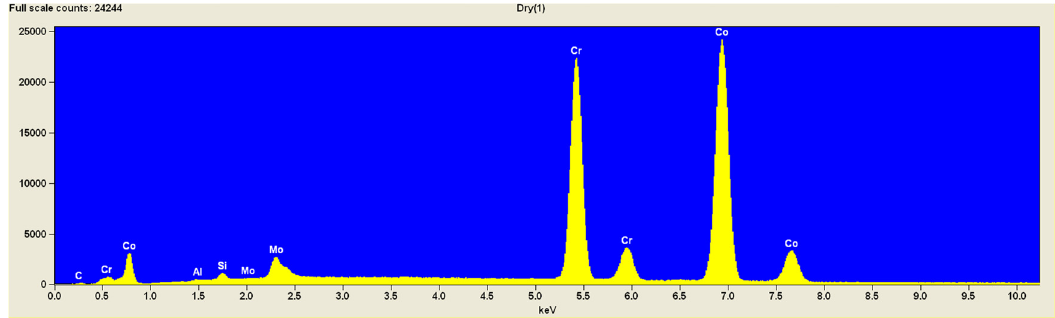
Figure 2: EDS analysis for a positive control group stored in 5.0% NaOCl.